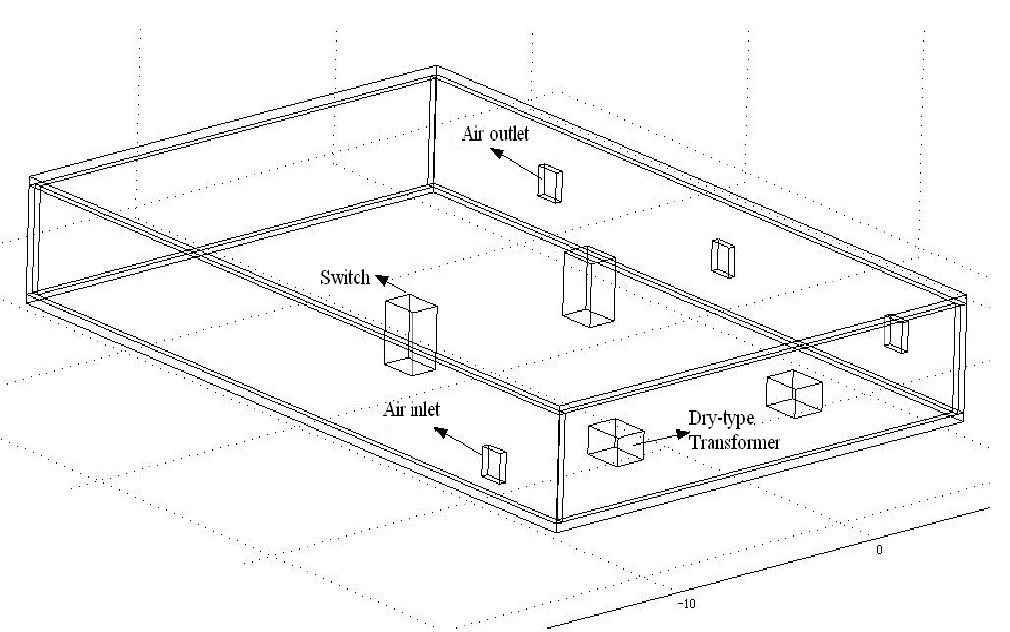
Figure 1. Physical model of the DSS (two transformers, two HV switchgears, one air inlet and two air outlets are considered in the model).